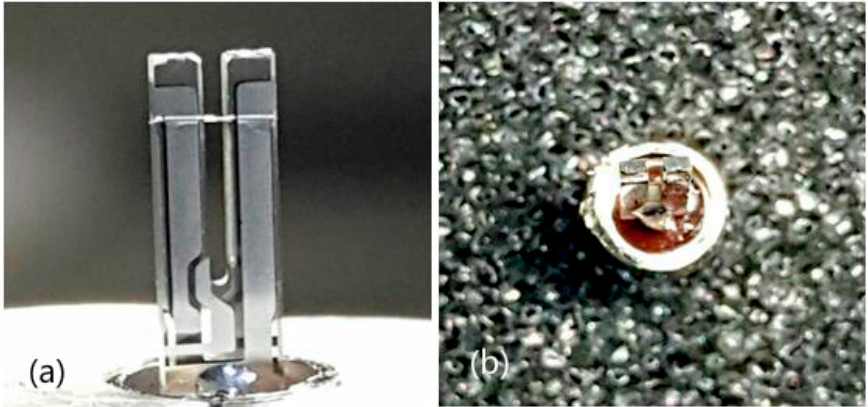
Figure 1. Photograph of a quartz tuning fork (QTF) with polymer microwire bridged across its prongs under a 45× stereomicroscope: ( a ) front view, ( b ) top view.